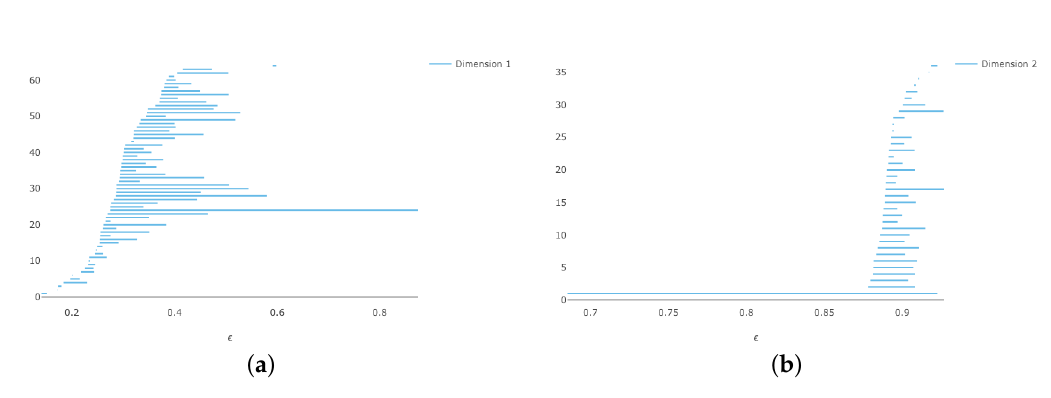
Figure 4. Vietoris–Rips persistence diagrams for 200 points on R P 2 ( a ) H 1 persistence and ( b ) H 2